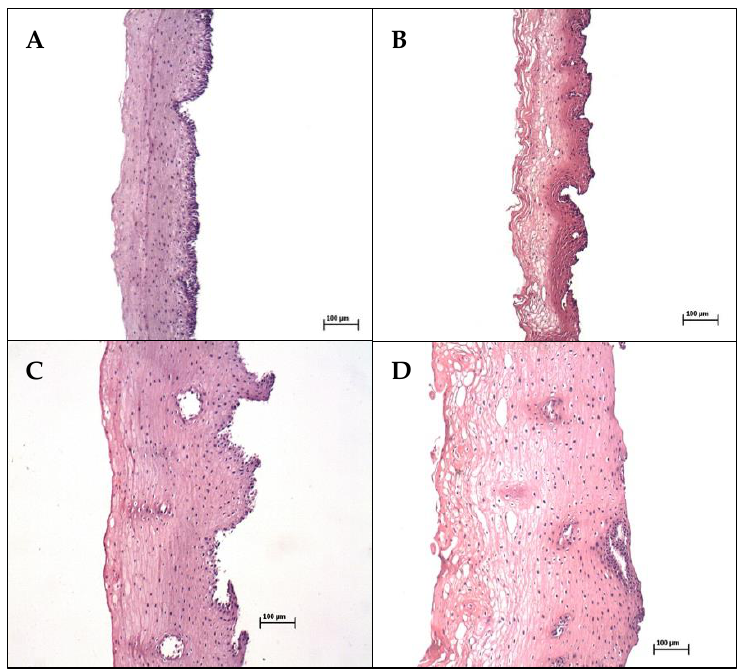
Figure 3. Histological sections of fresh (left panel) and frozen (right panel) epithelia from esophageal (upper images) ( A , B ) and buccal (lower images) ( C , D ) mucosas.